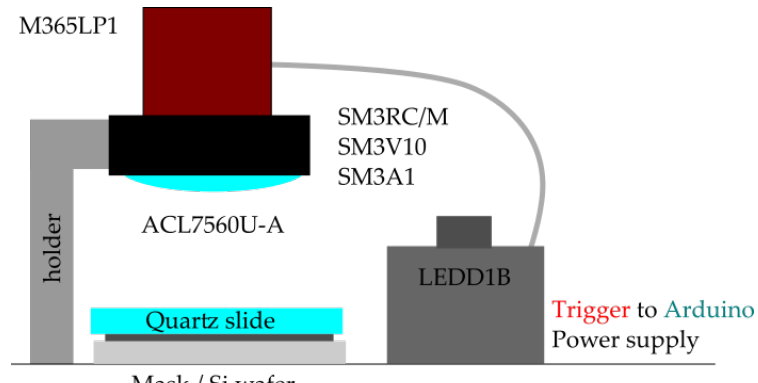
Figure A2. Schematic diagram of the set-up.